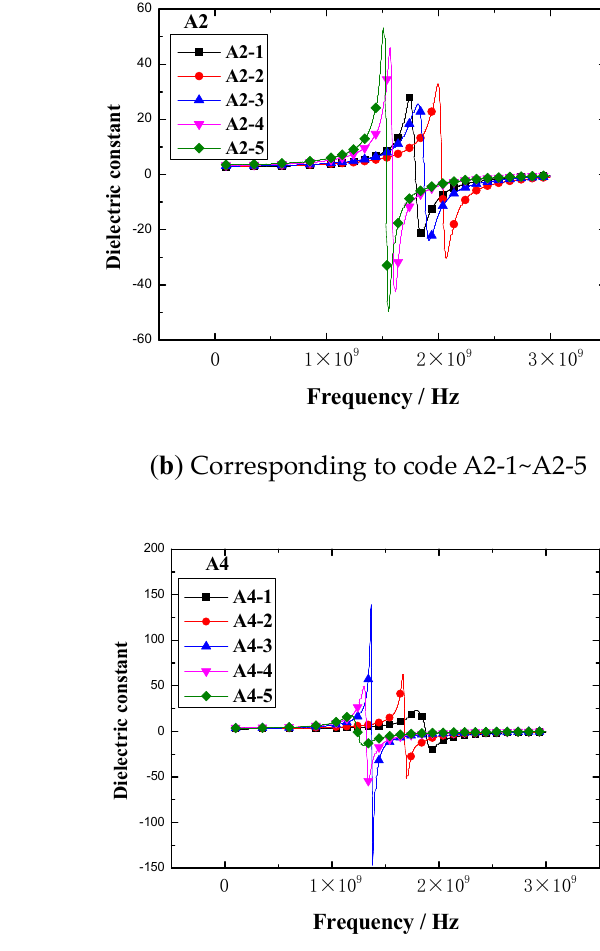
The peak frequency(GHz) The peak of dielectric constant